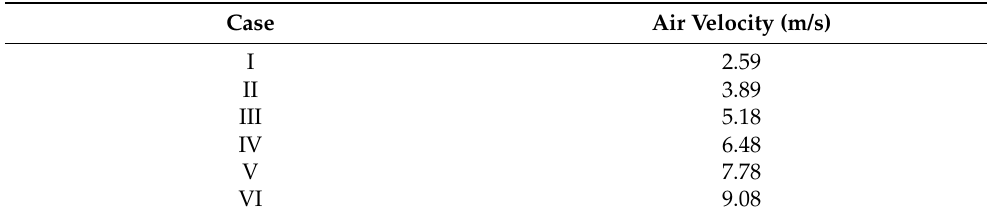
Table 2. Inlet air velocity for each case study.